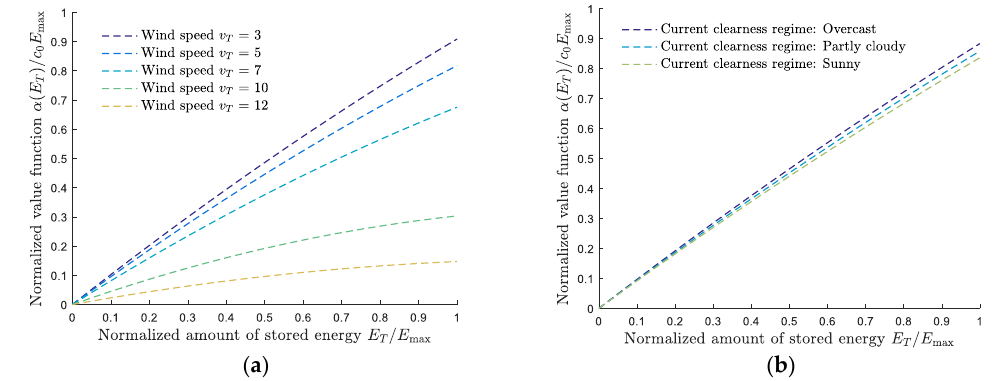
Figure 6. Estimated future value of stored energy as a function of the amount of stored energy for different wind speeds for the case of wind power ( a ) and for different cloud cover conditions (clearness regimes) for the case of PV ( b ).